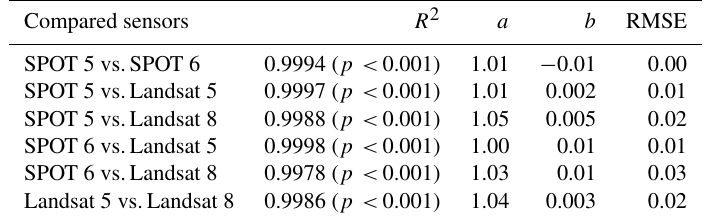
Table 3. SPOT and Landsat NDVI interconsistency based on the reflectance spectra of a benthic diatom library. Compared sensors R 2